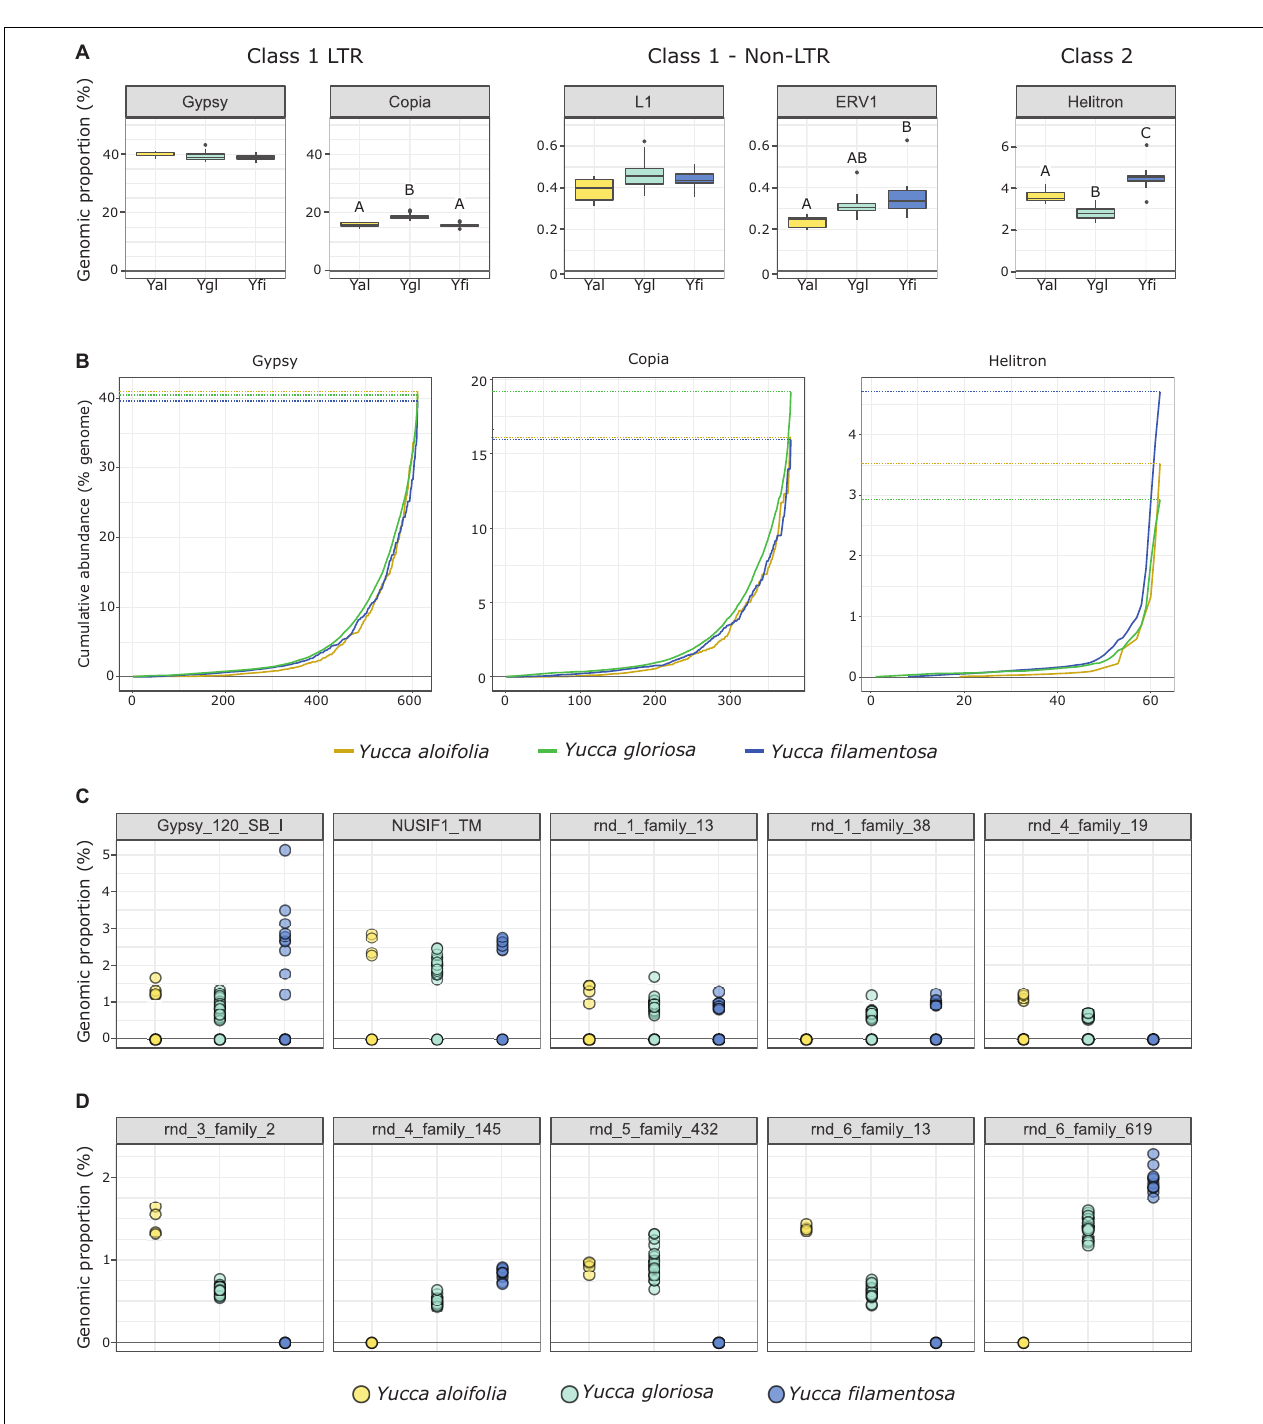
FIGURE 4 | (A) The genomic proportion (as a%) of the genome of a subset of transposable element families in Y. aloifolia (yellow), Y. gloriosa (teal), and Y. filamentosa (blue). Letters indicate significant differences based on Tukey post hoc tests from an ANOVA (abundance ∼ species) per repeat superfamily; shared letters indicate no significant difference at p < 0.01. y -axes are scaled by category (LTR, non-LTR, Class II). (B) Cumulative abundance of individual families per superfamily, ordered from lowest average abundance to highest average abundance. (C,D) Individual genotype abundance values for the five most abundant families in Gypsy (C) and Copia (D)